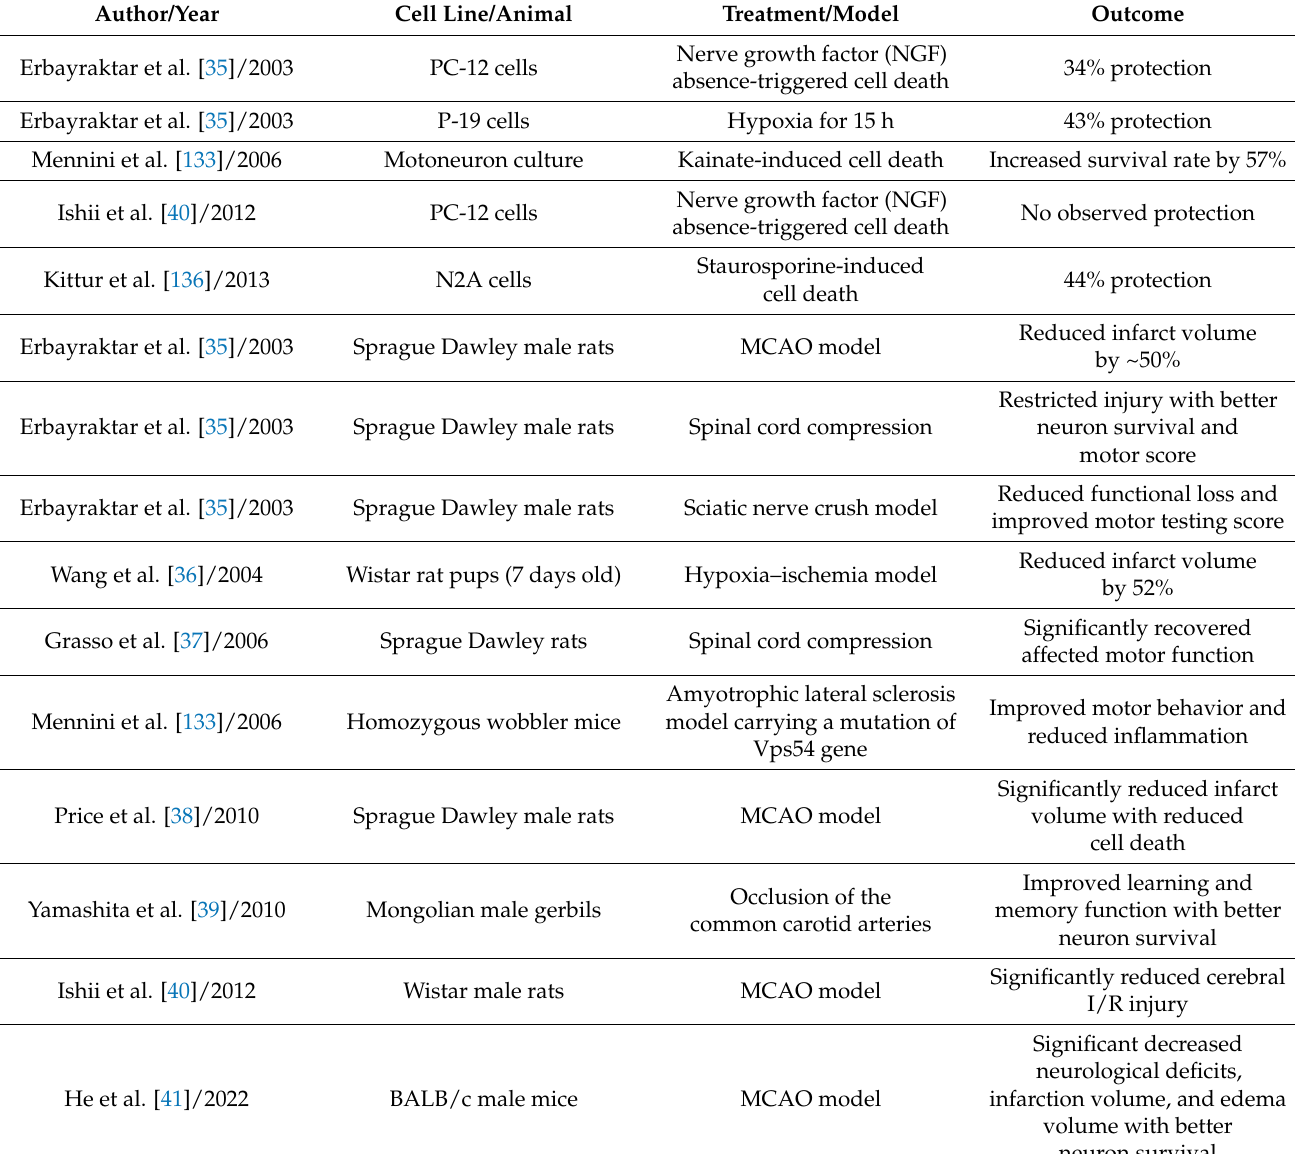
Table 3. In vitro and in vivo neuroprotective effects of